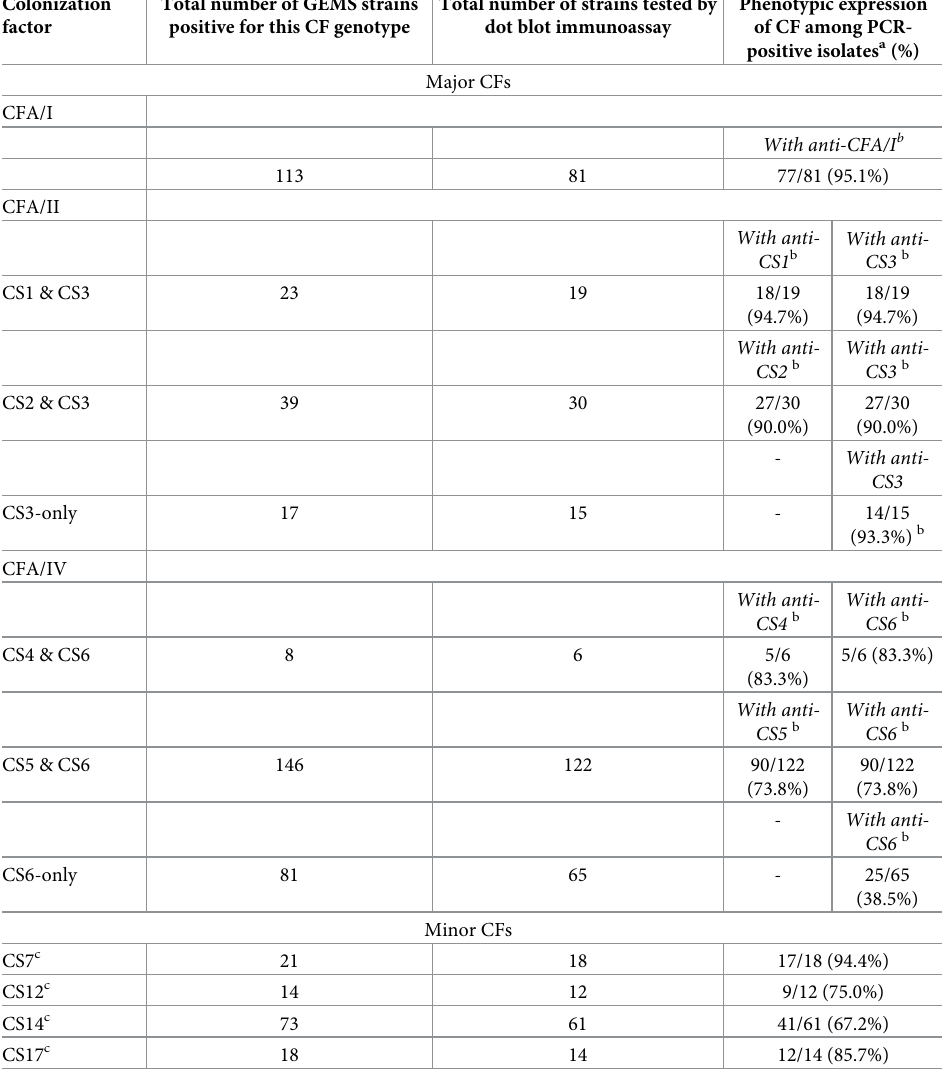
a Number of isolates positive by dot blot immunoassay/total number of PCR-positive isolates tested b Antibody used in the dot blot immunoassay c Negative for all other colonization factors. Dot blot immunoassays were performed with the homologous